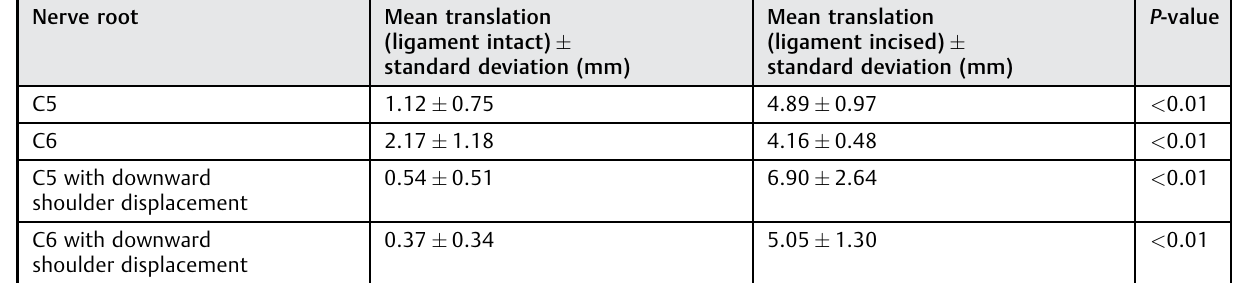
Table 1 Mean nerve root translation before and after ligamentous release, with and without downward shoulder displacement Nerve root Mean translation (ligament intact) (cid:3)